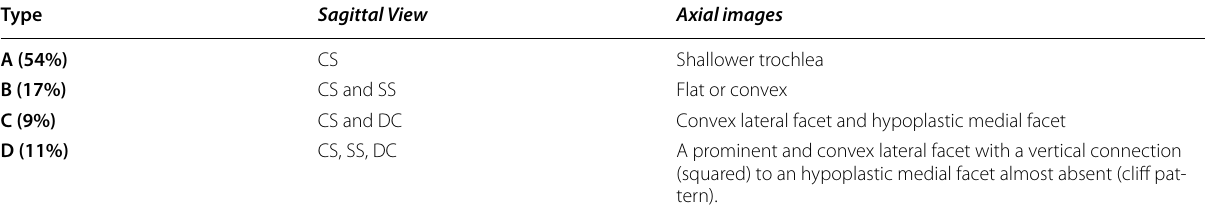
Cross-checking the radiographic sagittal view and the cross-sectional images is fundamental to include a patient within one of those trochlear types CS Crossing sign, SS Supratrochlear spur, DC Double contour